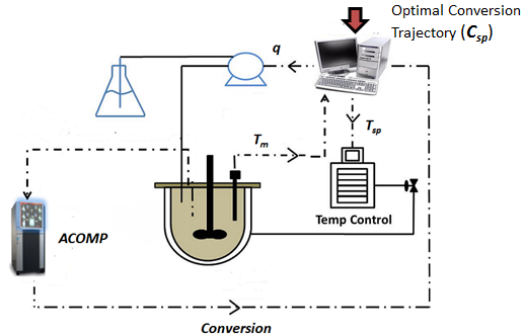
Figure 12. Schematic of apparatus and sensors for the proposed control strategy.